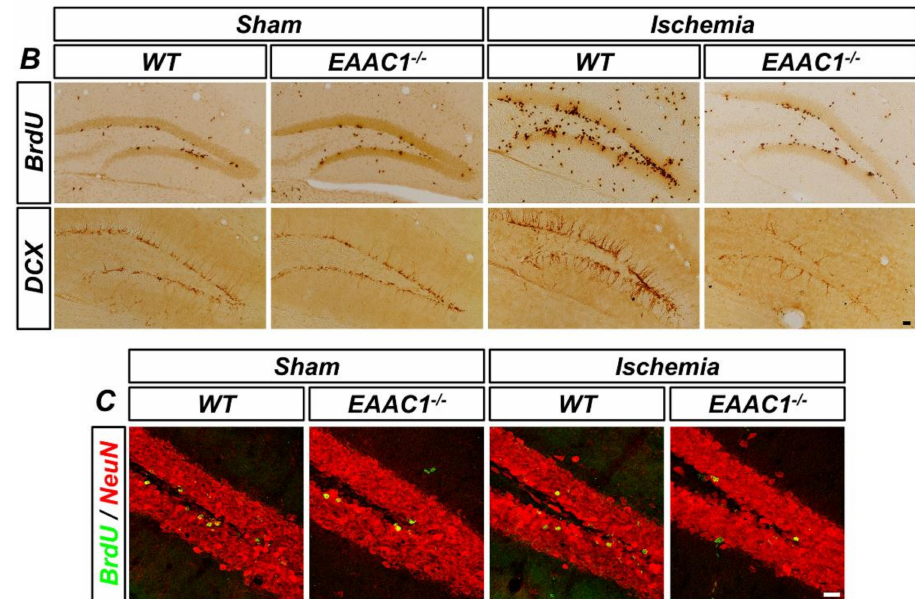
Figure 4. Genetic deletion of EAAC1 reduces adult hippocampal neurogenesis after ischemia. ( A ) The schematic drawing shows that cell proliferation and neuronal di ff erentiation are reduced in the EAAC1 − / − mice after ischemia, which means that EAAC1 gene deletion influences the entire process of adult neurogenesis. ( B ) Representative images showing the bromodeoxyuridine (BrdU)- and DCX-positive cells in the hippocampal DG from WT and EAAC1 − / − mice (3–5 months old; weight 25–35 g) at 7 days after ischemia or sham surgery. Scale bar = 50 µ m. ( C ) Double-label confocal micrographs of BrdU (green) and neuronal nuclei (NeuN) (red) in the hippocampal DG from WT and EAAC1 − / − mice (3–5 months old; weight 25–35 g) at 30 days after ischemia or sham surgery. Scale bar = 20 µ